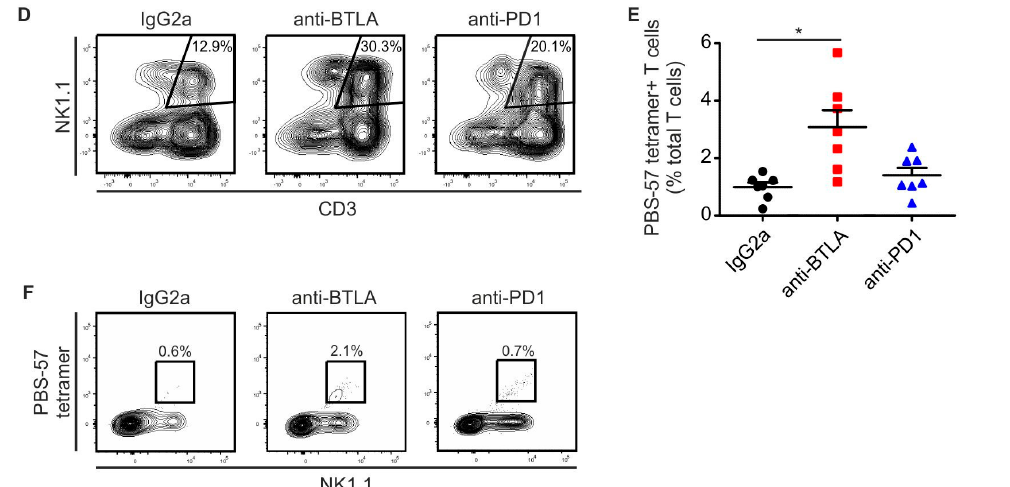
Figure 3. Anti-BTLA antibodies increase tumor infiltrating NKT cell numbers. PyMT tumors were treated with 5 mg/kg of each anti-BTLA, anti-PD-1 or isotype control (IgG2A) antibodies ( n = 7 each) twice weekly for three weeks once the first tumor reached a size of 0.5 cm in diameter. Tumors were harvested for FACS analysis 21 days after initial treatment. ( A ) Representative FACS plots show gating strategy to identify cellular subsets in PyMT tumors. ( B ) The relative abundance of tumor cells, CD45+ immune cells, fibroblasts and endothelial cells in the total single cell population is shown. ( C ) The relative abundance of myeloid and lymphoid cell subsets within total CD45+ cells is displayed. ( D , E ) The graph indicates the relative abundance of PBS-57-CD1d tetramer reactive type I NKT cells. ( F ) Representative FACS plots indicate the expansion of PBS-57-CD1d tetramer reactive type I NKT cells upon anti-BTLA treatment. p -values were calculated using one-way ANOVA with Bonferroni’s correction, * p < 0.05. Int. J. Mol. Sci. 2018 , 19 , x FOR PEER REVIEW